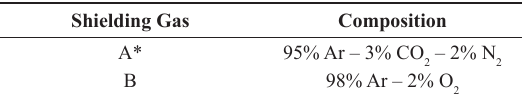
Figure 1. Schematic model for double-ellipsoid heat source 33 Table 3. Shielding gas composition.